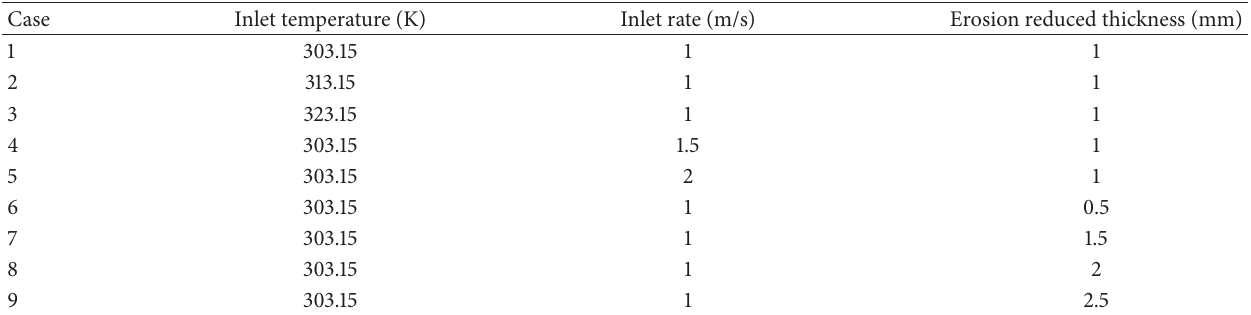
Table 2: Simulation